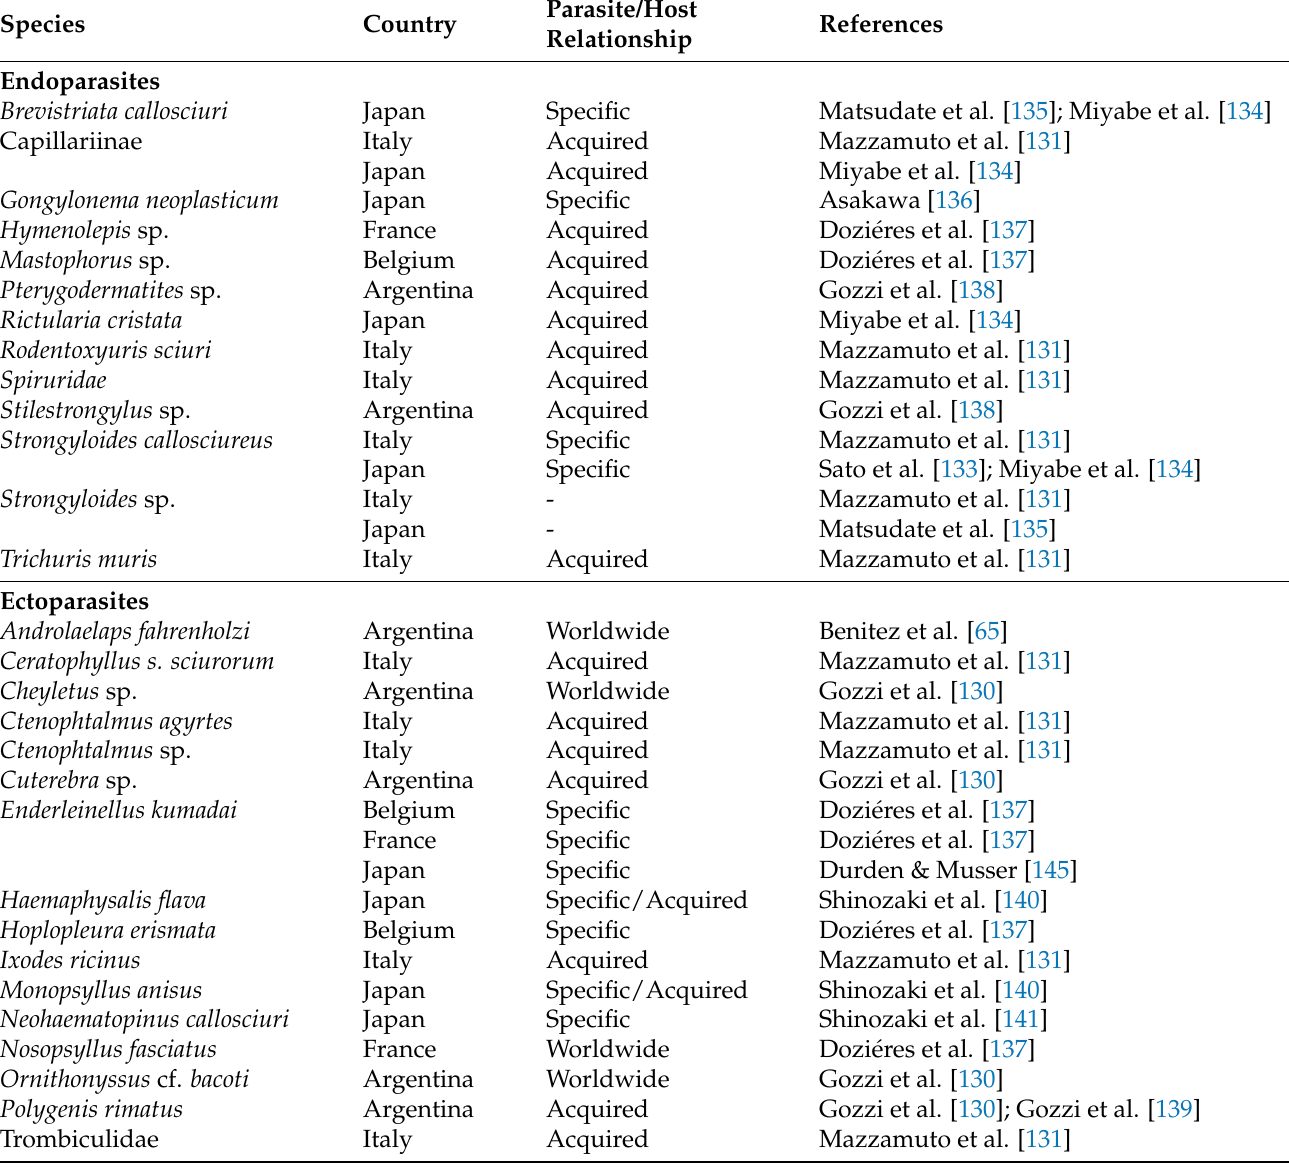
Table 2. Macroparasites of Pallas’s squirrels in their areas of